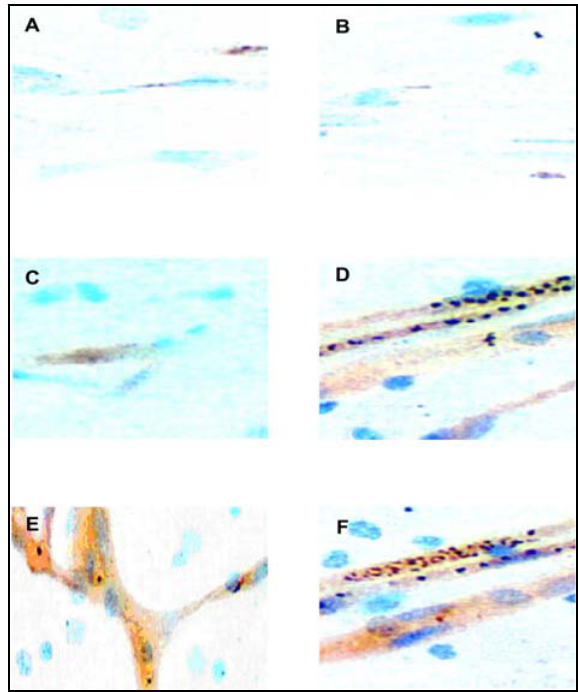
1A-F (original magnification, X400) : Immunohistology for ICAM-1, VCAM-1 & E-selectin. (A-B) Sections of non-malaria cases: (A) Staining for ICAM-1: positive in < 25% of brain